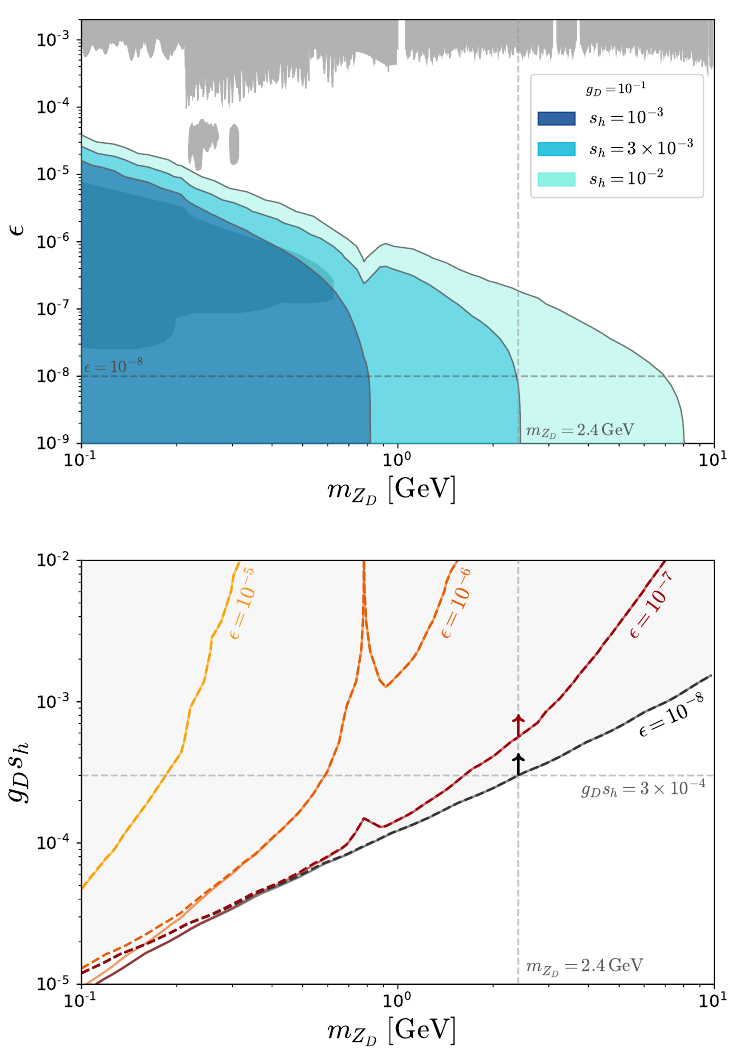
Figure 10 . In the upper panel we show the bound on m Z × (cid:15) obtained by using the CMS limit D BR inv < 0 . 19 [65] for s h = 10 − 3 (blue), 3 × 10 − 3 (cyan) and 10 − 2 (light blue) and dark gauge eff coupling fixed to g D = 10 − 1 . In the lower panel we show the same, but in the plane m Z × g D s h D and for (cid:15) = 10 − 5 (yellow), 10 − 6 (orange), 10 − 7 (red) and 10 − 8 (black). The dependence on the dark Higgs mass m S can be neglected in the mass range considered here. In the upper (lower) panel the curves are limited from above (below) by the condition that the dark photons must decay outside the CMS detector, but are unlimited from below (above). For a fixed value of m Z we can read D from the lower plot the exclusion limit on g D s h for different choices of kinetic mixing (cid:15) , as indicated by the arow for m Z = 2 . 4 GeV (vertical dashed grey D